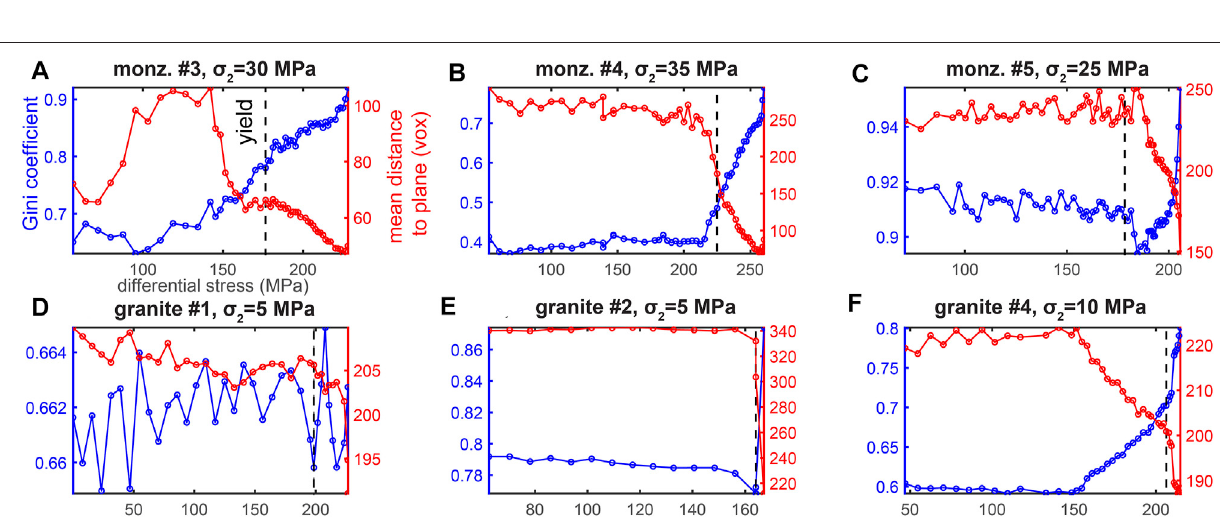
r 2 score and mean distance between the fractures and the plane in the initial and fi nal scans acquired in each experiment ( Figure 10 ). The monzonite experiments experience larger r 2